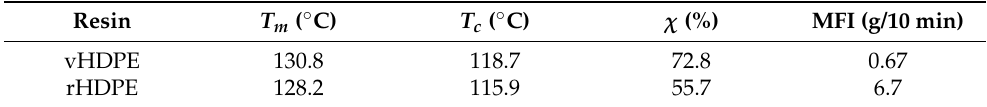
Figure 2. DSC thermograms of vHDPE and rHDPE.